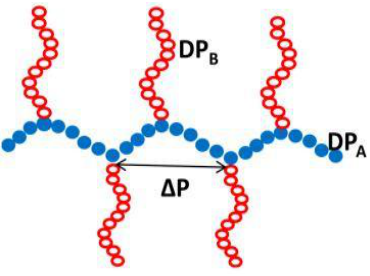
Figure 9. Schematically representation of an AB graft copolymer.